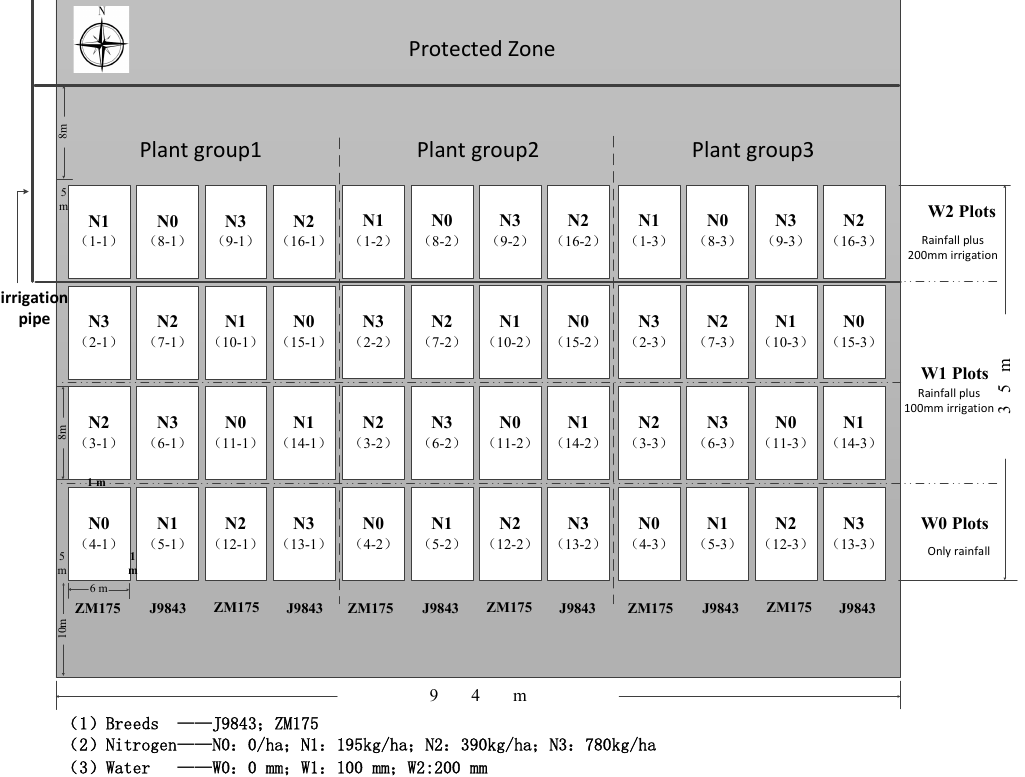
Figure 2. Experimental details. Plants were divided into three groups, with a total of 16 winter wheat plants per group. Planting area was 6 × 8 m, and each group received different fertilization and irrigation treatments.